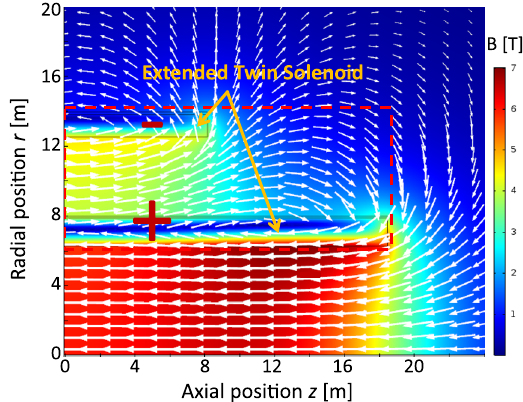
FIG. 6. Two-dimensional axisymmetric representation showing half of a very long twin solenoid. This magnet configuration provides the same field integral at j η j ¼ 4 as the shorter twin solenoid in combination with two balanced forward solenoids (Fig. 5), but the stored energy is more than twice as